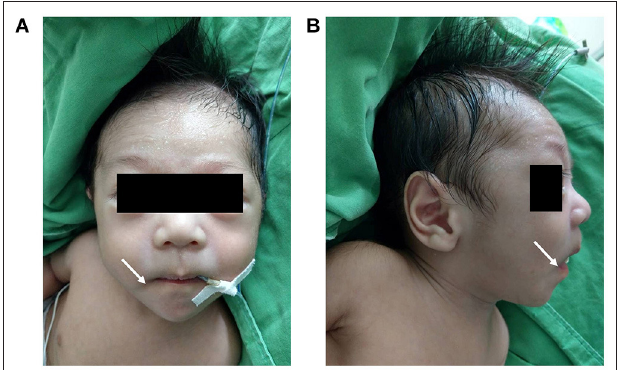
FIGURE 2 | Anterior and lateral views of the patient’s face (A,B) revealing dolichocephaly, a down-turned mouth (indicated by the white arrow), a triangular face and diaphoresis on the forehead.